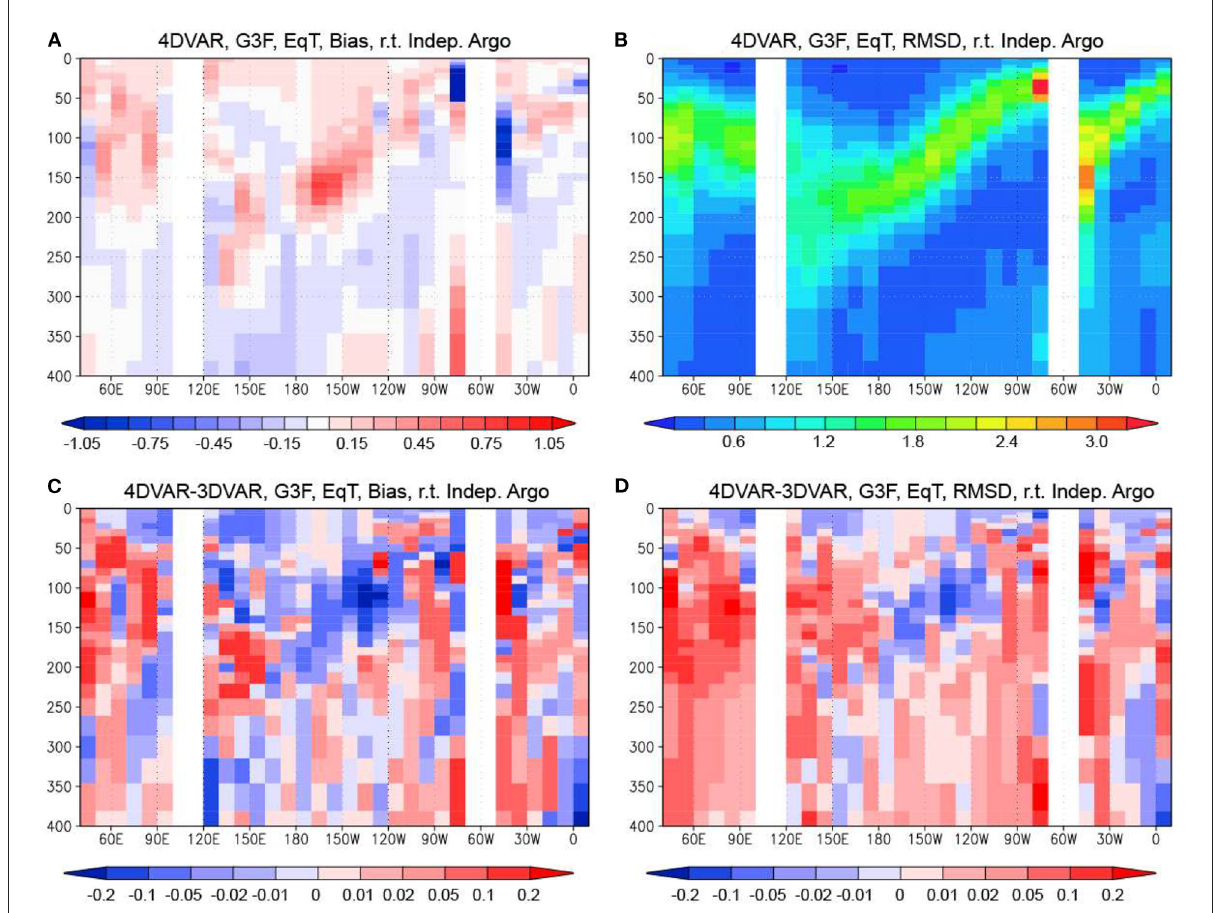
FIGURE10 (A, B) Bias and RMSD of the MOVE-G3F temperature at the equatorial vertical section (average of two boxes within 5 ◦ S − 5 ◦ N) in the 4DVAR Run. 3DVAR Run Difference of the bias absolute values and RMSDs of the MOVE-G3F temperature between the 4DVAR and 3DVAR Runs at the equatorial vertical section. The biases and RMSDs are relative to the independent Argo float data. Blue colors in (C, D) mean that the bias absolute value or the RMSD is smaller for the 4DVAR Run. Units in ◦